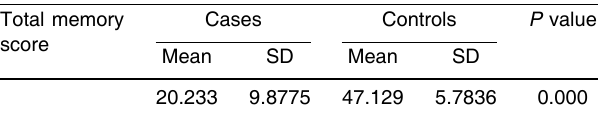
Table 1 Comparison of total memory scores between cases and